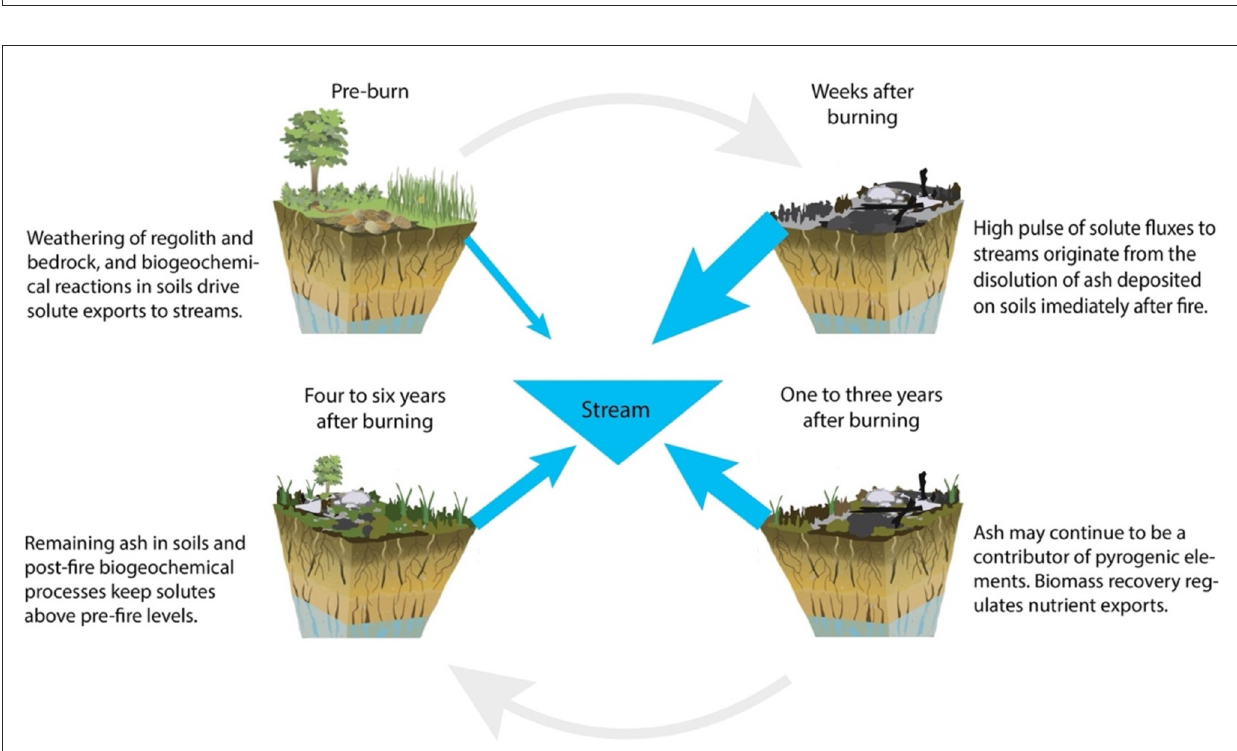
FIGURE8 Conceptual model of evolution of solute exports after fire. Blue arrows represent the magnitude of solute mobilization in the three periods after burning—a few weeks after fire, 1–3 years after fire, and 4–6 years post-burn. Figure modified from Chorover et al. (2007).